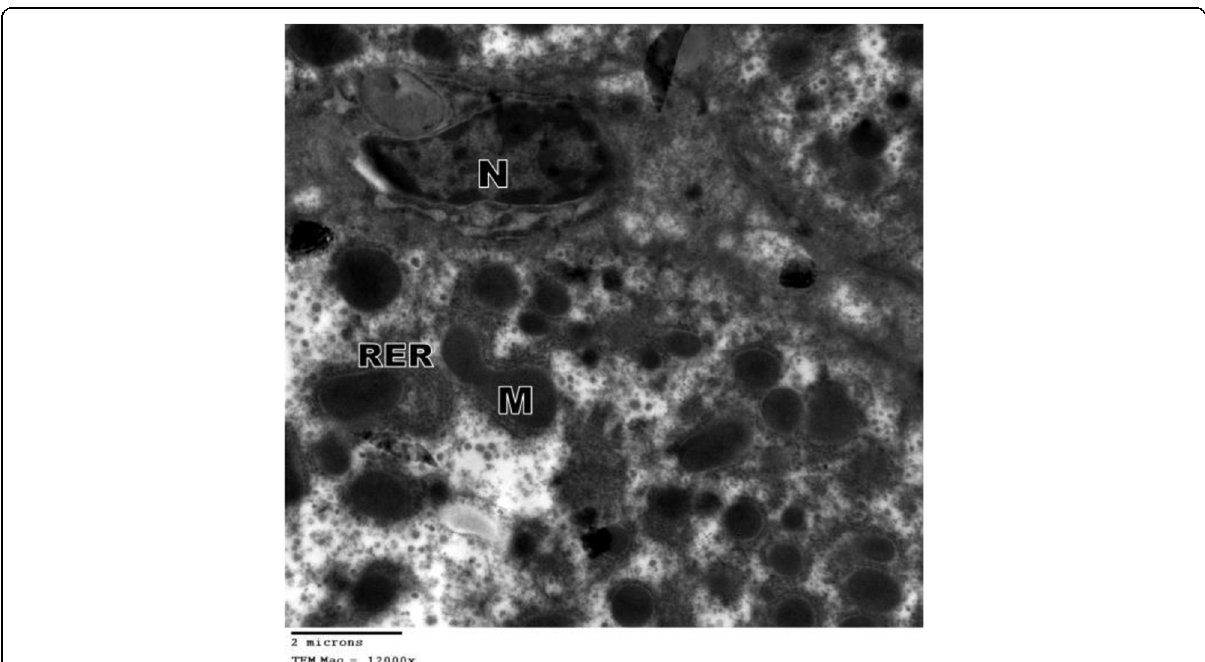
Fig. 21 An electron micrograph of a hepatocyte of treated mouse with Adamine (20 mg/kg b.wt.) for 5 days showing rough endoplasmic reticulum (RER), and condensed mitochondria (M) lost its cristae and pyknotic nucleus (N) of a Kupffer cell. (× 12,000)